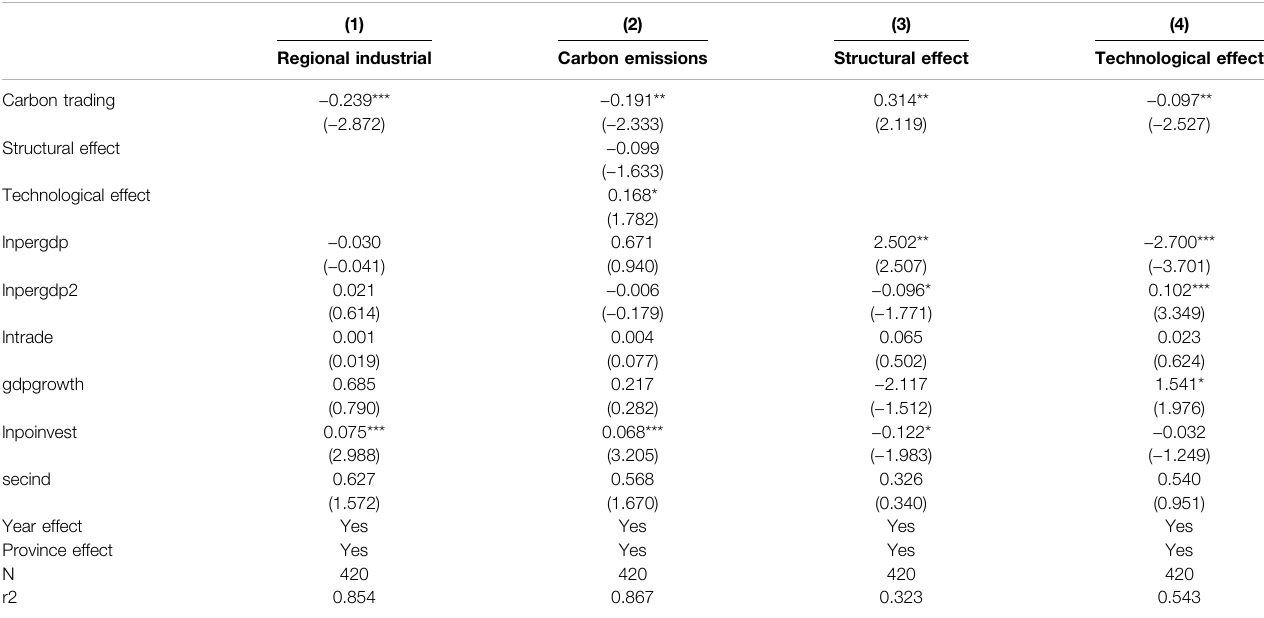
TABLE 4 | Mechanism veri fi cation of the impact of carbon trading on regional industrial carbon